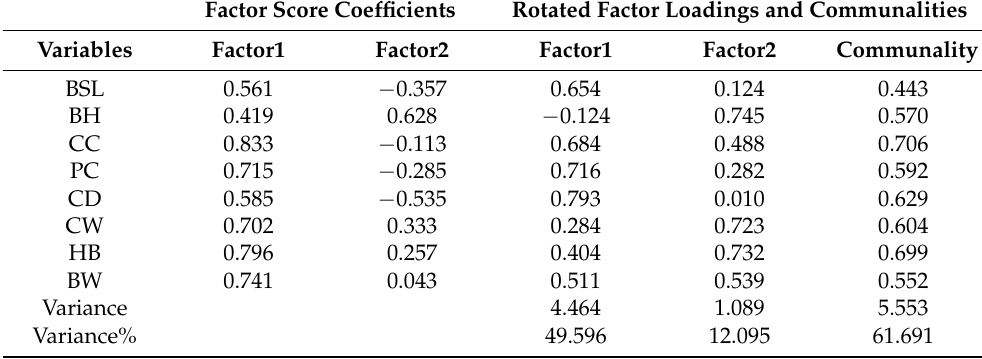
Table 5. Factor analysis